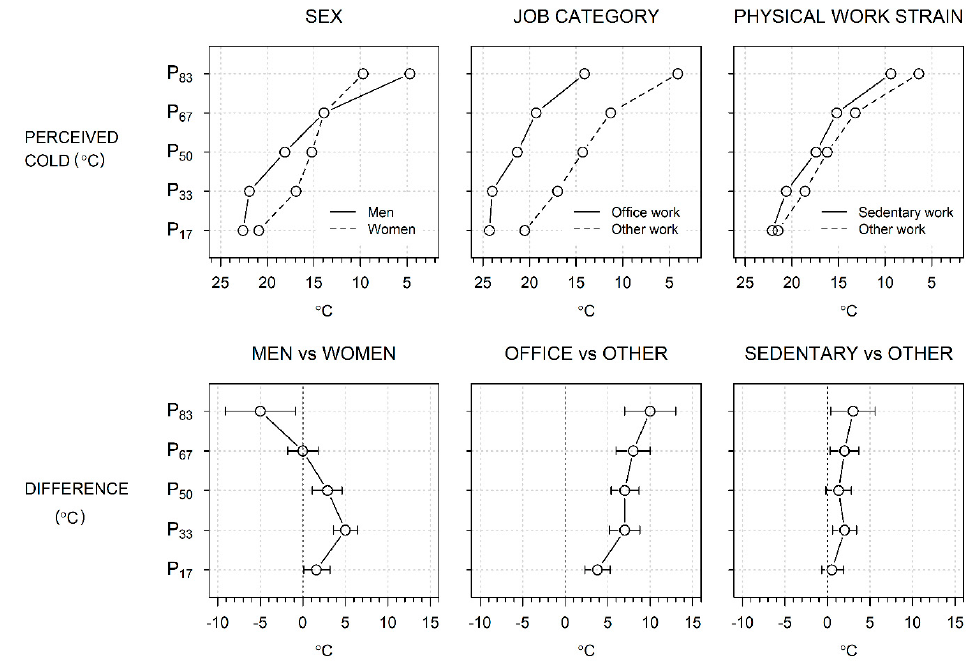
Figure 3. Model-based adjusted threshold for cold ( ◦ C) by percentiles (P 17 : warmest, P 83 : coldest), broken down by sex, job category, and physical strain at work (upper row) and their groupwise differences (lower row).